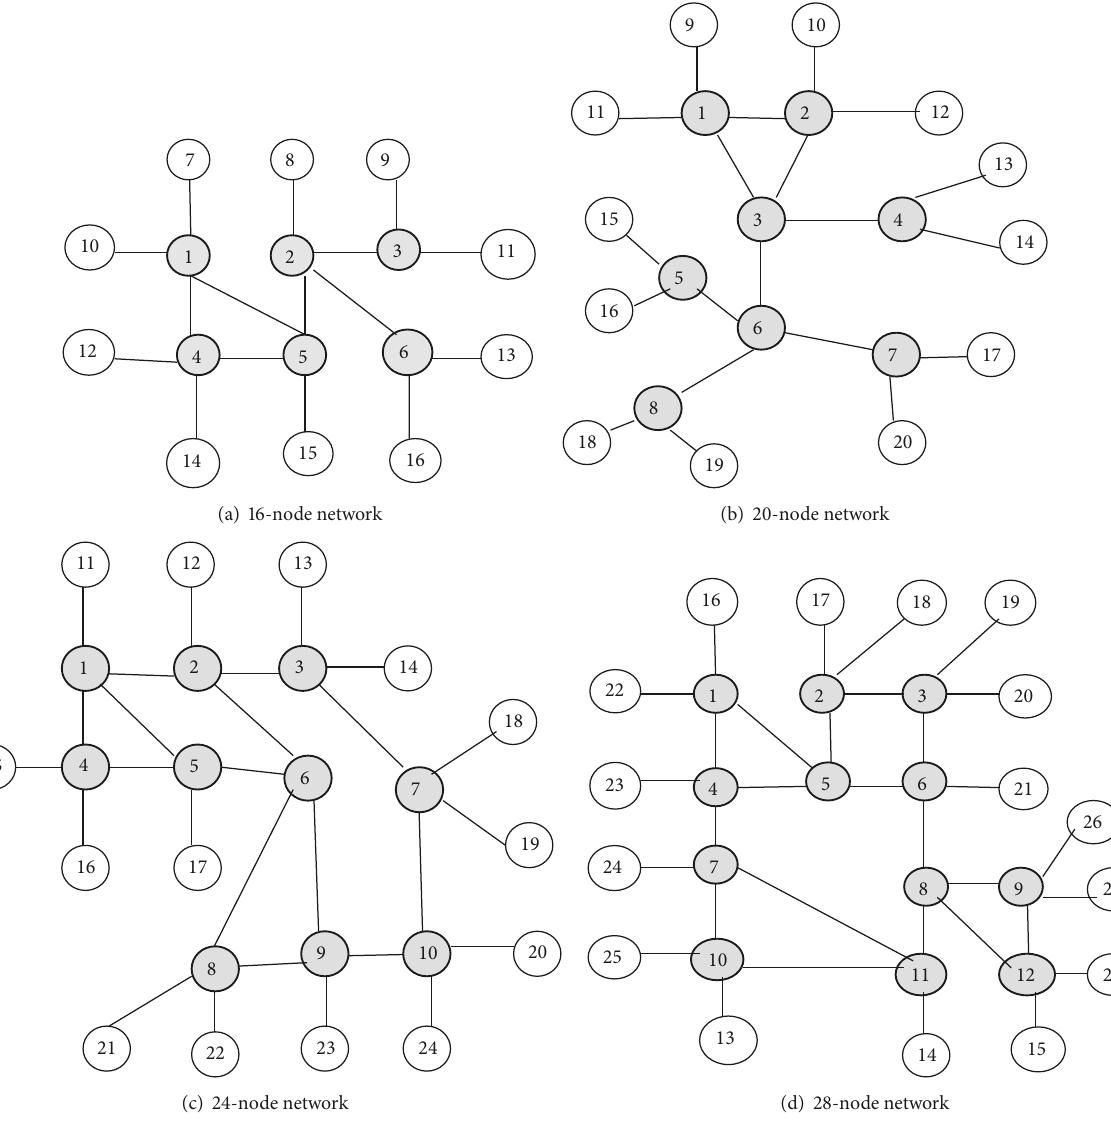
Figure 7: 16-, 20-, 24-, and 28-node test network.